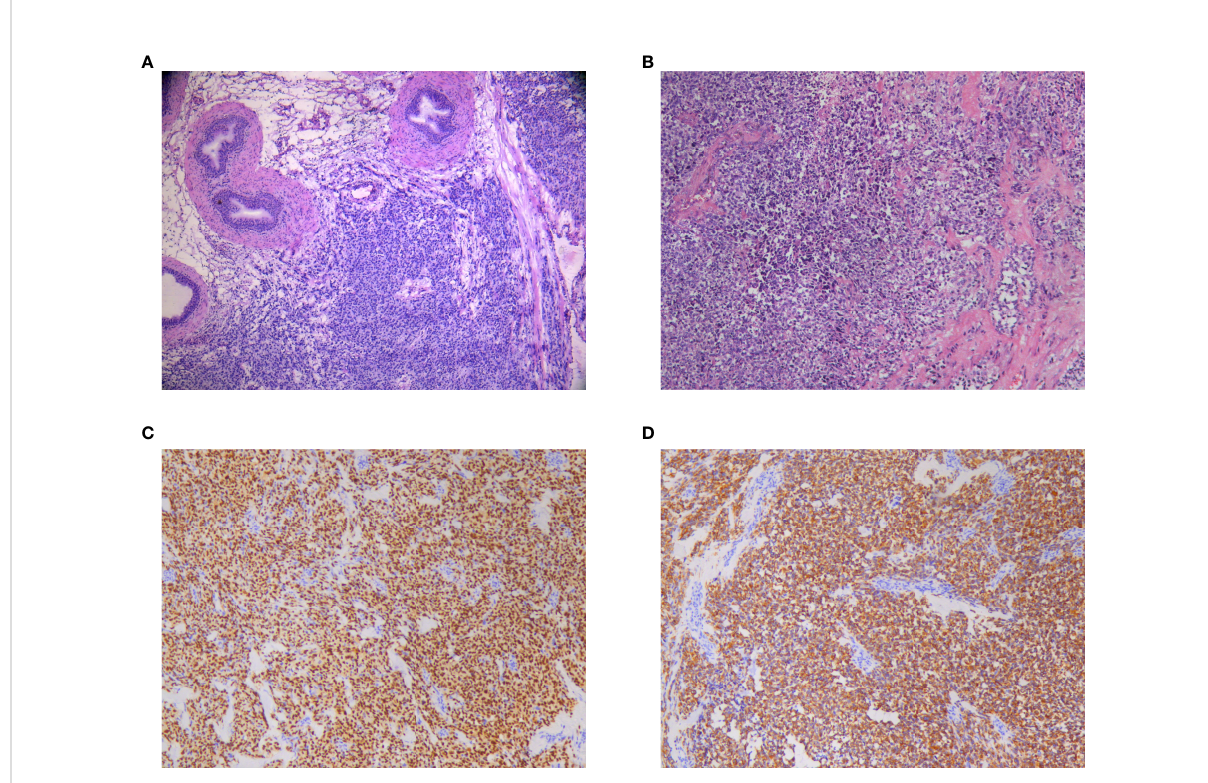
FIGURE 2 Microscopic pathology of primary eRMS. (A) Heterotypic cells were seen between the tissues of the right epididymis; (B) tumor size was about 3.5×3.2×2.5 cm; (C) Desmin (+); (D) Myogenin